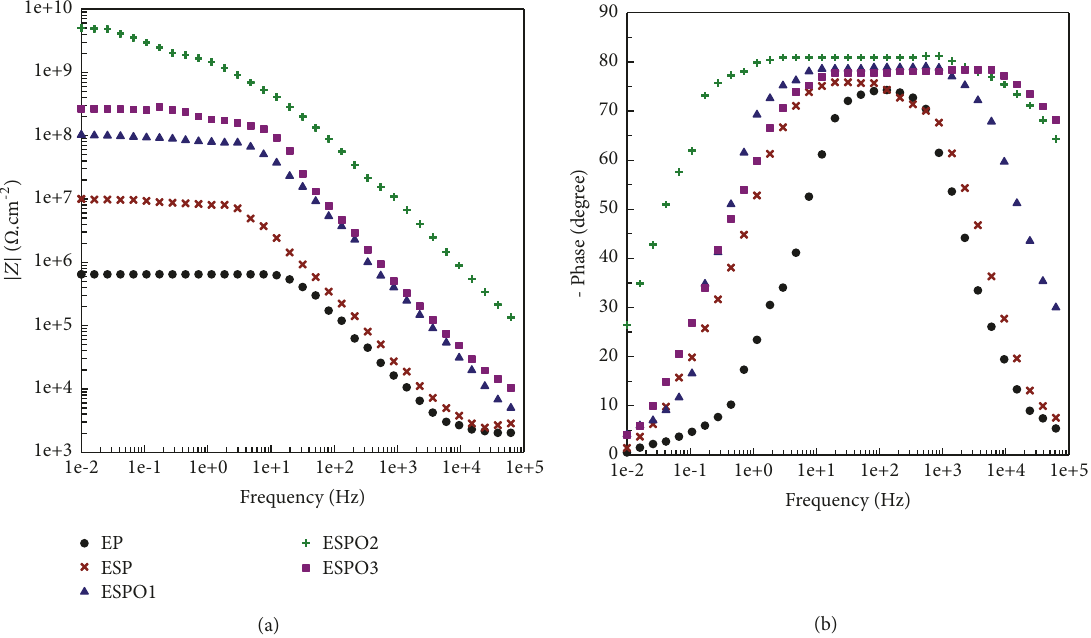
Figure 7: Bode plots of coatings after 1 hour of immersion in a 3% NaCl